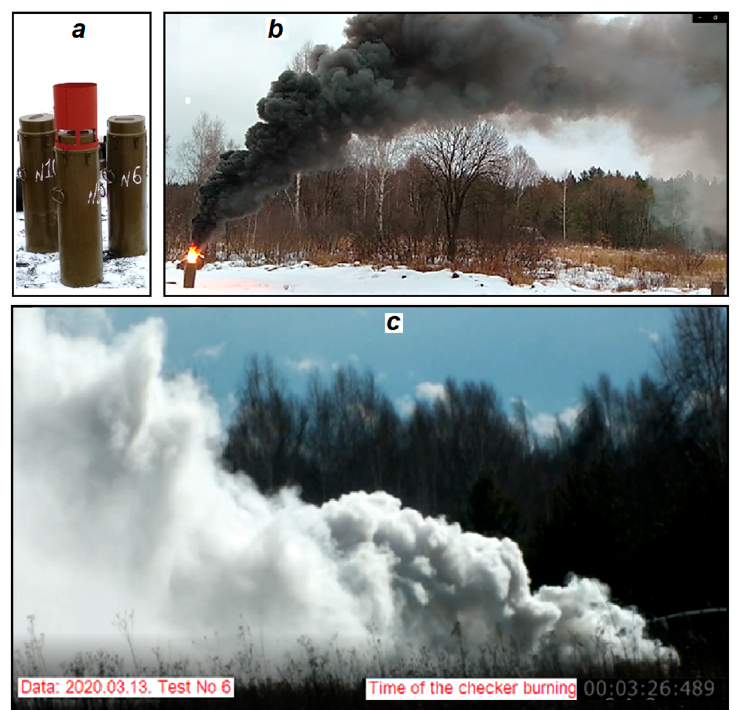
Figure 13. Aerosol checkers ADSH-1 with and without an injector ( a ) and aerosol plumes created by the ADSH-1 ( b ) and ADSH-2 ( c ) cartridges. Videos of tests of all cartridges are available.